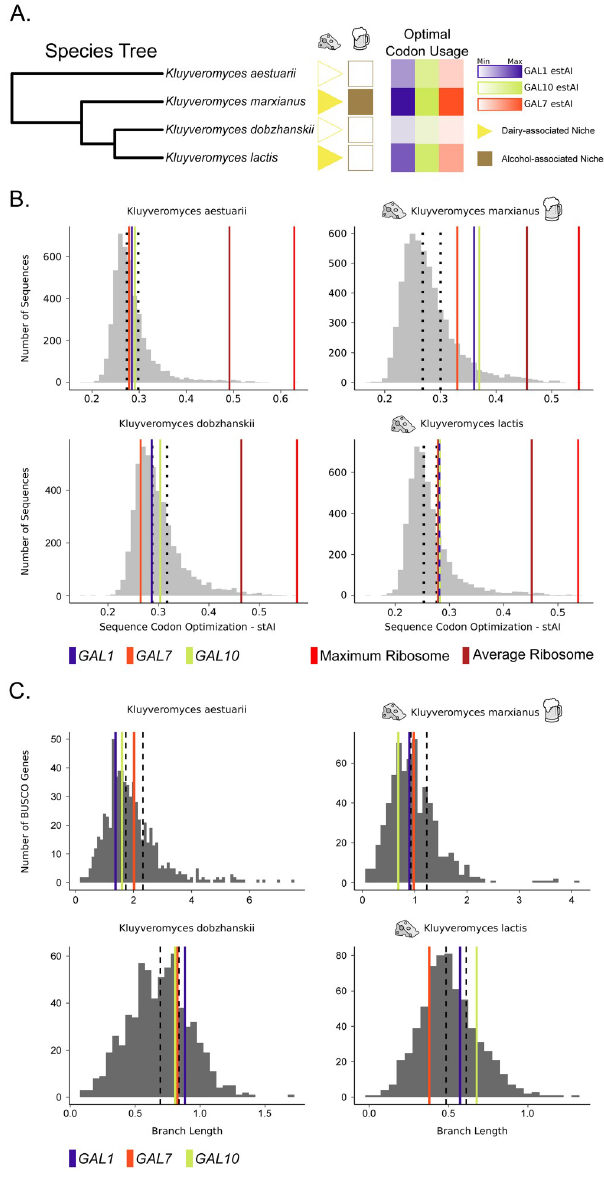
Fig 4. Closely related Kluyveromyces species exhibit differential codon optimization in the GAL pathway associated with isolation from dairy environments. All 4 Kluyveromyces species were shown experimentally to metabolize galactose. (A) Species phylogeny of 4 closely related Kluyveromyces species. K . marxianus and K . lactis are both associated with dairy niches and have high codon optimization values in their GAL pathway genes. In contrast, K . aestuarii is associated with marine mud, and K . dobzhanskii is associated with flies. (B) The genome-wide distribution of codon optimization (stAI) values for the 4 Kluyveromyces species included in this study. The 50th and 75th percentiles are shown with black dashed lines. In the 2 species associated with dairy niches, the codon optimization for all 3 GAL genes falls in the top 25th percentile. In the 2 species not associated with dairy, the GAL genes fall below the top 25th percentile. Genes encoding ribosomal proteins are well established to rank among the most highly optimized genes within a genome. (C) The distribution of terminal synonymous (dS) branch lengths (in unrooted gene trees) calculated for the 651 BUSCO genes. All 3 GAL genes fall within the interquartile range for K . aestuarii and K . marxianus . In K . dobzhanskii , all 3 GAL genes lie above the 70th percentile with GAL1 in the upper quartile. In K . lactis , GAL7 falls below the interquartile range, while GAL10 lies above. The 50th and 75th percentiles are shown with black dashed lines. Underlying data can be found in Tables G–P S4